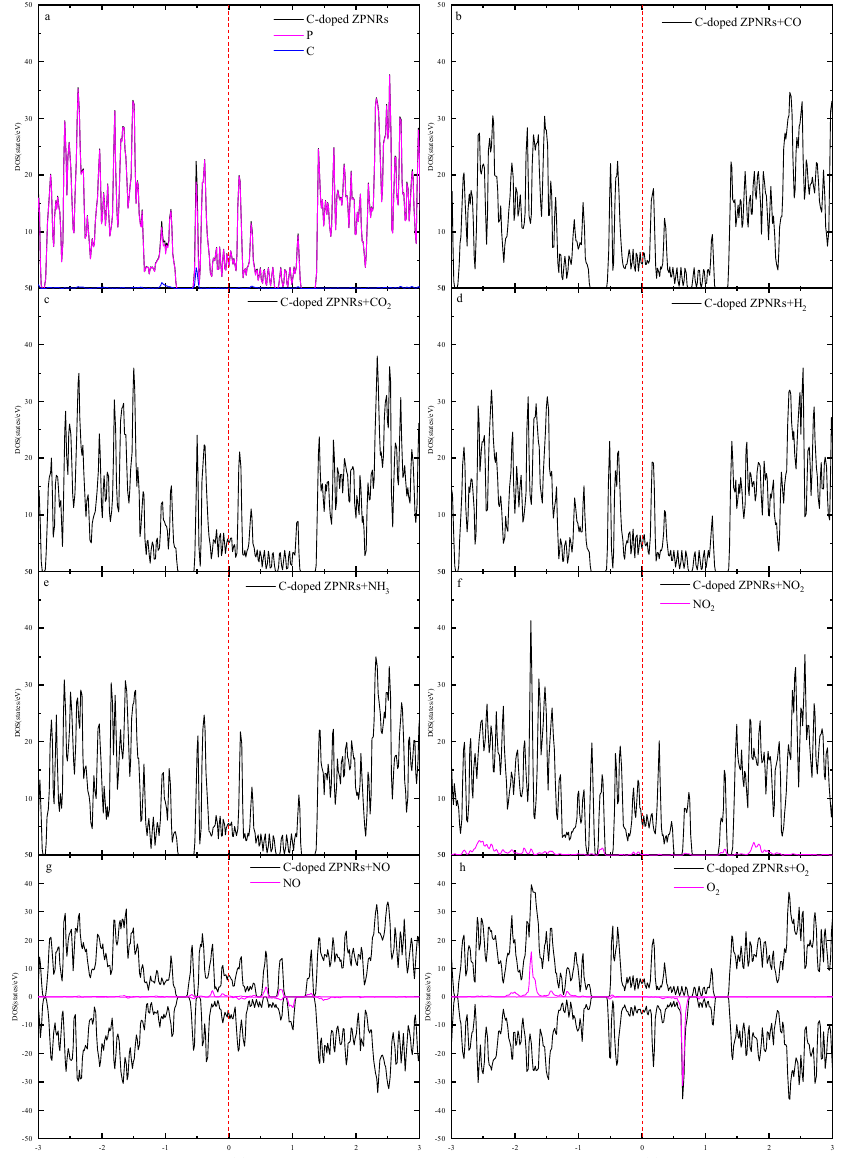
Figure 4. Density of states (DOS) of C-doped ZPNRs ( a ) and the projected density of states (PDOS) of the C-doped ZPNRs with CO ( b ), CO 2 ( c ), H 2 ( d ), NH 3 ( e ), NO 2 ( f ), NO ( g ) and O 2 ( h ) adsorbed. The Fermi energy is shifted to zero as indicated by the vertical dotted red line.